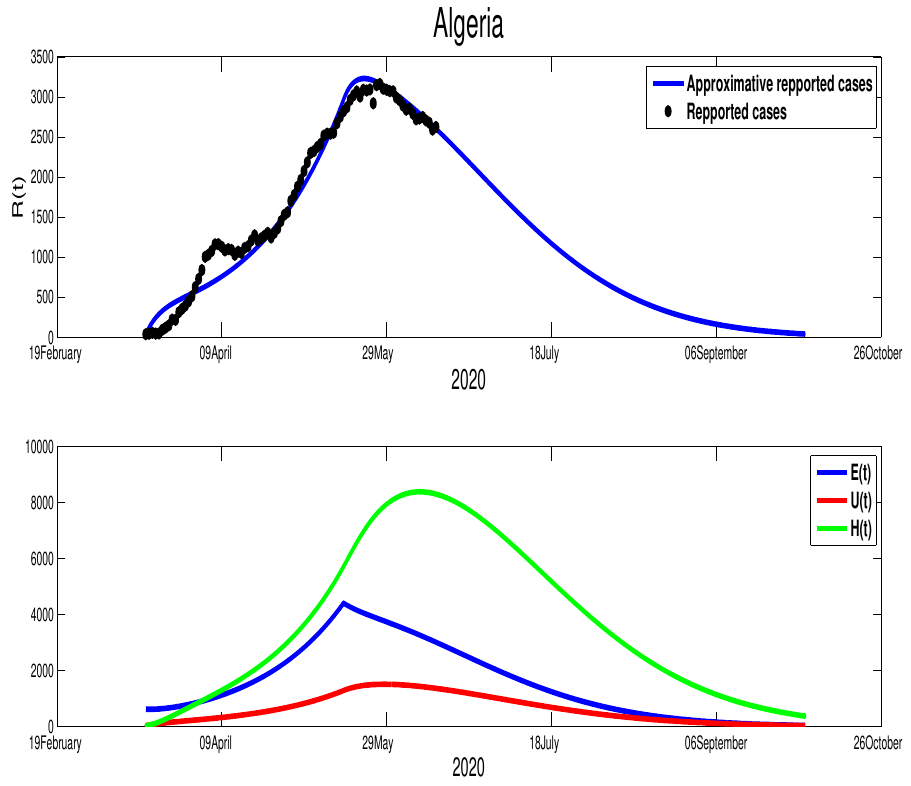
Figure 7. The predictive results for